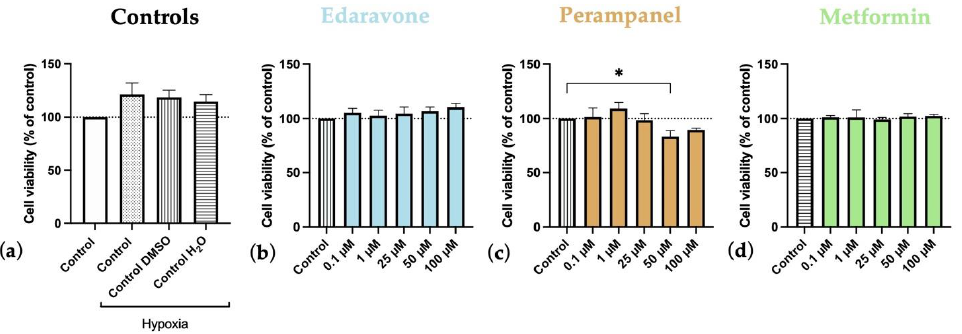
Figure 10. Effects of hypoxia, and edaravone, perampanel, and metformin treatments on SH-SY5Y cells viability. Hypoxia and drugs were applied simultaneously for 48 h. ( a ) Controls graph, com- paring controls/vehicles in hypoxic conditions to normoxia ones. ( b ) Edaravone, ( c ) Perampanel, and ( d ) Metformin treatments, while in hypoxia. Cell viability was assessed by MTT assay, to each treatment after exposure. Results are expressed in the percentage of cell viability relative to untreated hypoxia-control cells and submitted to hypoxia in ( b – d ). * indicate p < 0.05, when compared to hypoxia-control. All data are presented as the mean + SEM of three independent experiments.